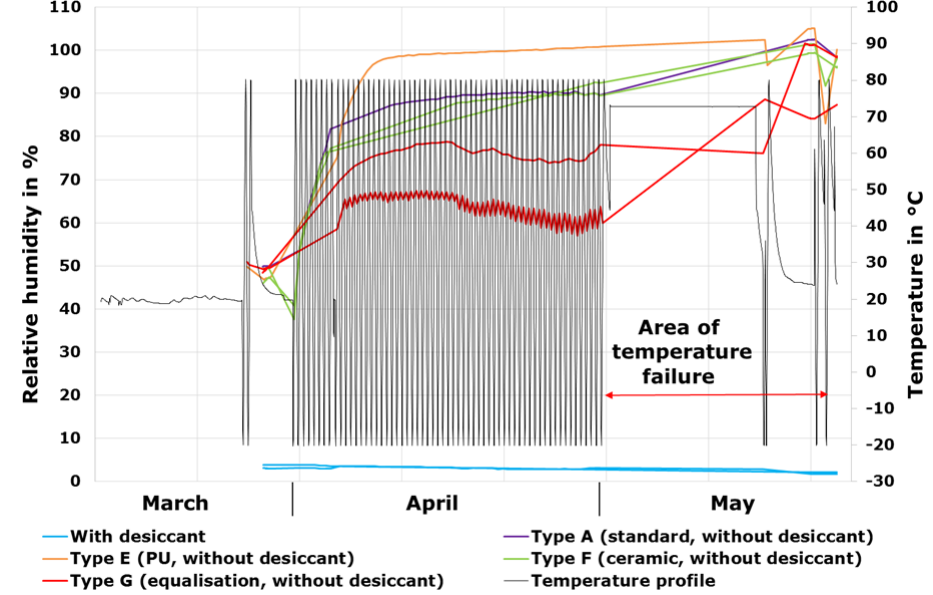
Fig. 7 Relative humidity and temperature in selected insulating glass